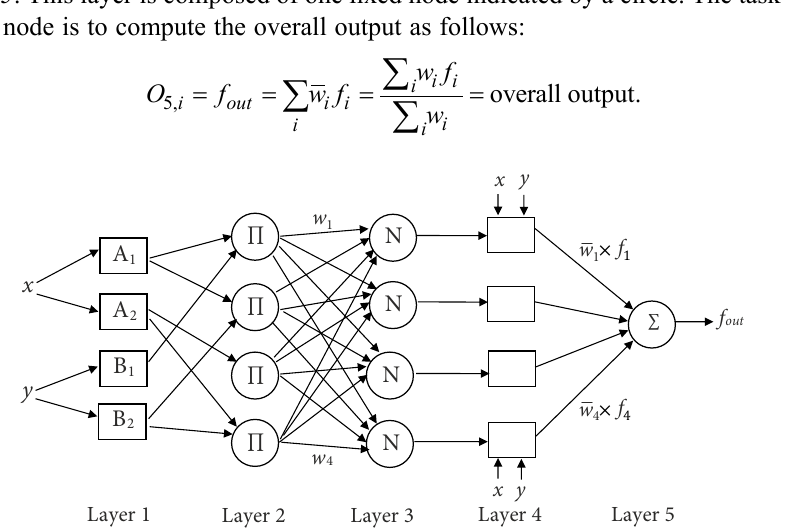
Fig. 1. ANFIS architecture with two inputs and four